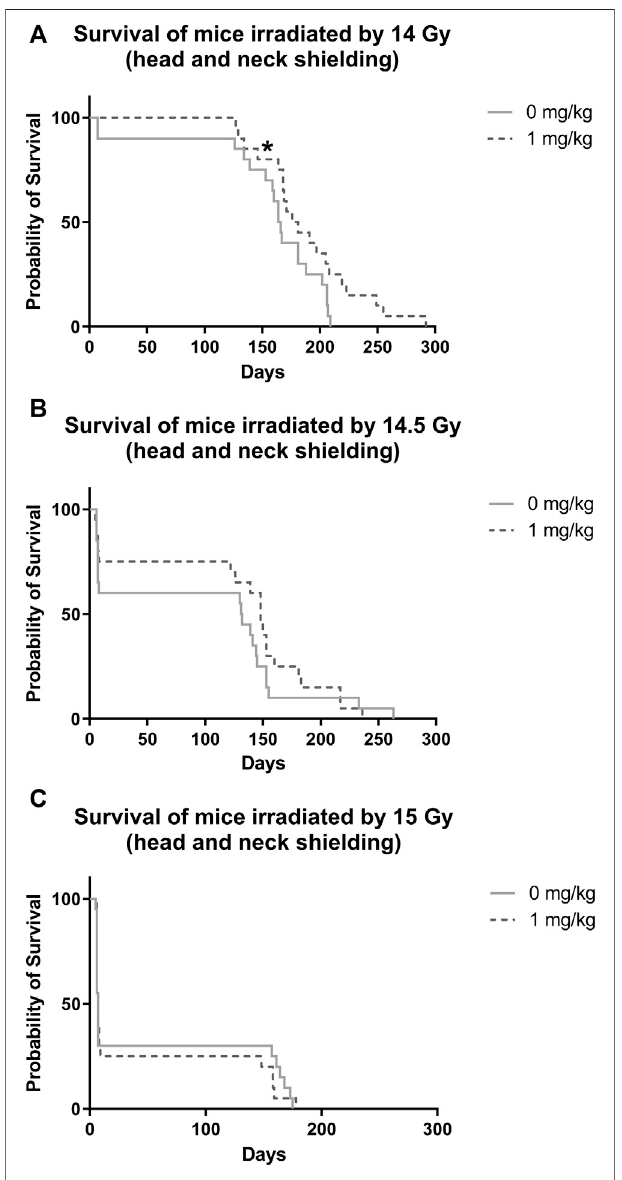
FIGURE 2 | Effect of IGF-1 at 1 mg/kg on irradiated mice ’ s survival with shielded head and neck. (A) 14 Gy. (B) 14.5 Gy. (C) 15 Gy. Signi fi cantly different when compared with the solely irradiated group receiving no treatment: * p ≤ 0.05.